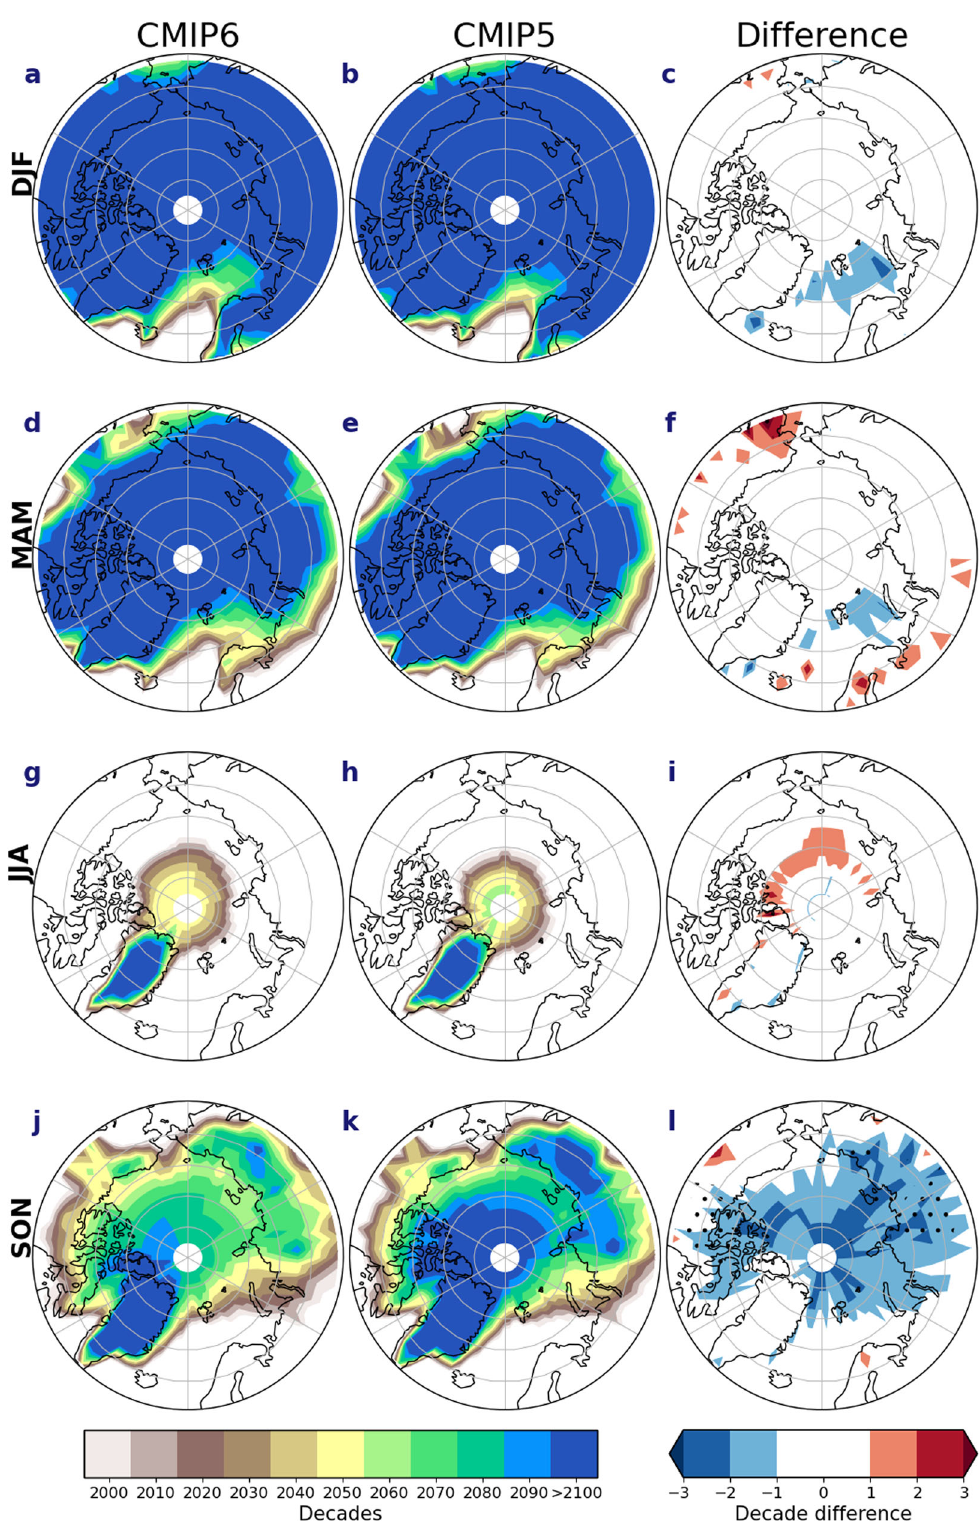
Fig. 8 Decade of transition between snow-dominated precipitation to rainfall-dominated precipitation and their differences. The decade of transition from a snow-dominated precipitation regime to a rain-dominated regime for CMIP6 [ fi rst column] and CMIP5 [second column] multi-model ensemble means, taken as when annual snowfall relative to annual precipitation falls below 50% and their differences [third column] for a – c December – February (DJF), d – f March – May (MAM), g – i June – August (JJA) and j – l September – November (SON). Areas that do not transition by 2100 are shaded in blue. Areas shaded in white in the fi rst two columns are rain-dominated before the year